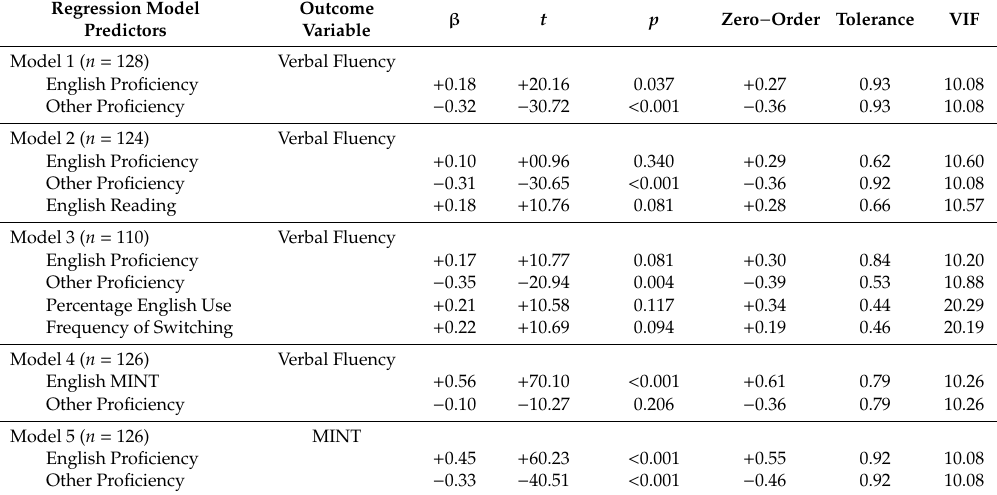
Table 3. Regression models predicting verbal fluency or scores on the Multilanguage Naming Task (MINT) as